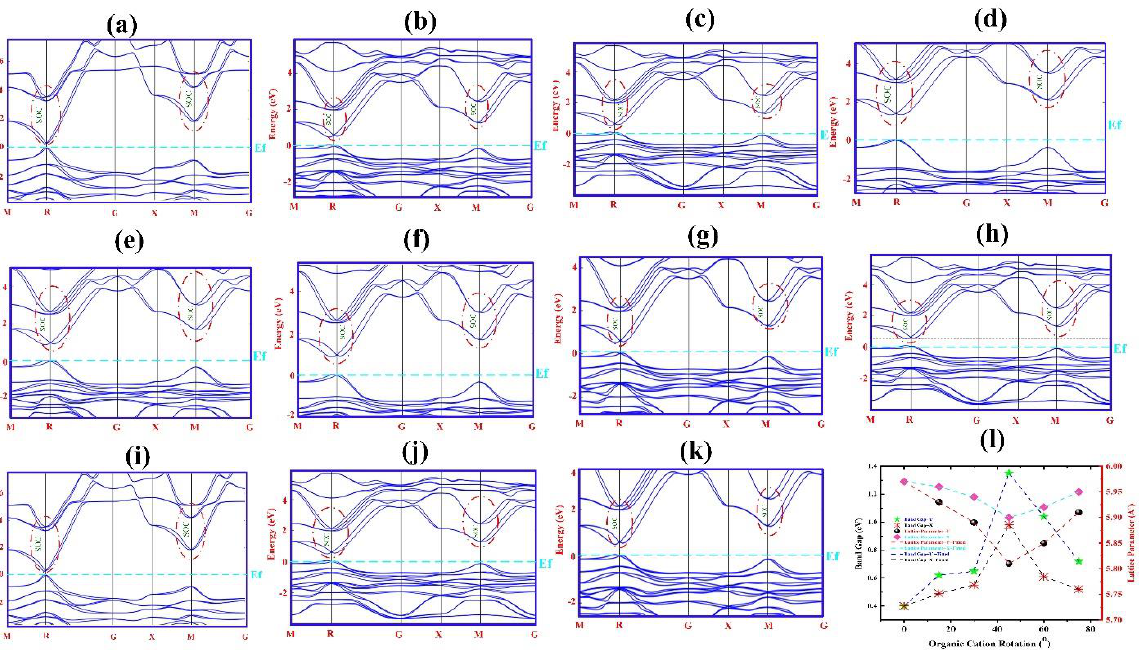
Figure 3. Calculated band structure of FAPbBr 3 perovskite with SOC for rotational modes of ( a ) 0 ◦ -X, ( b ) 15 ◦ -Y, ( c ) 30 ◦ -Y ( d ) 45 ◦ -Y, ( e ) 60 ◦ -Y, ( f ) 75 ◦ -Y, ( g ) 15 ◦ -X, ( h ) 30 ◦ -X, ( i ) 45 ◦ -X, ( j ) 60 ◦ -X and ( k ) 75 ◦ -X. ( l ) Variations of bandgap and lattice parameter in term of rotational orientation. SOC is shown with red dashed line in CBM.